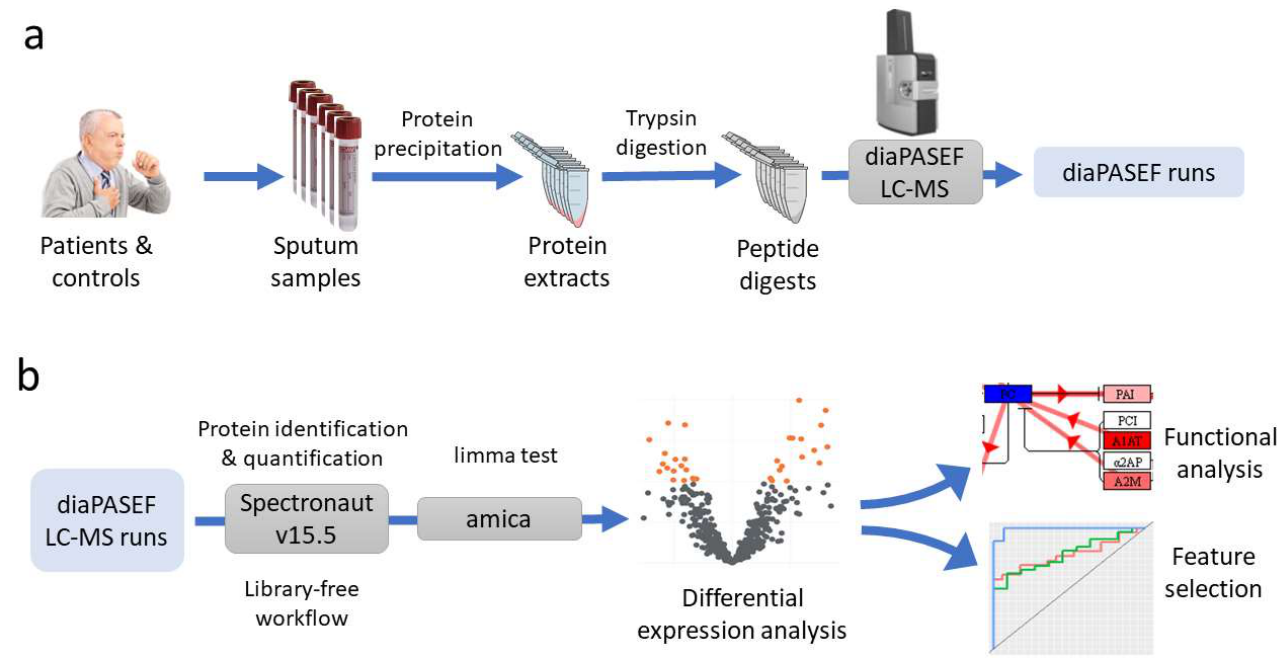
Figure 5. Proteomics workflow. ( a ) Sample preparation and LC-MS acquisition using diaPASEF, and ( b ) data analysis.